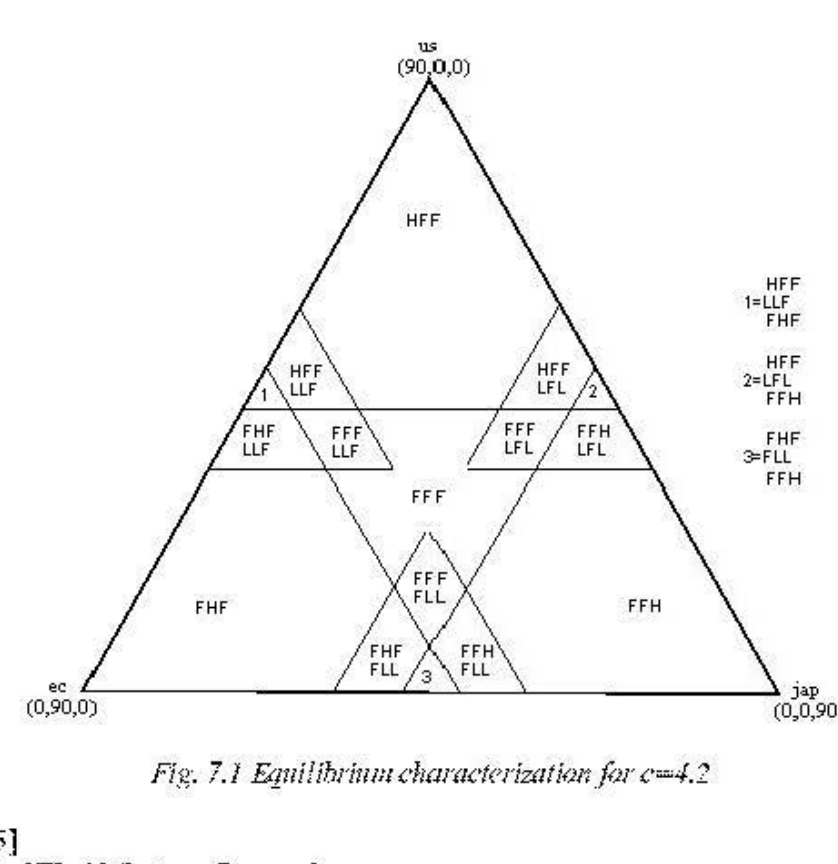
Fig. 7. l Equi ! ibrium chamderiwtior.for c=4.2